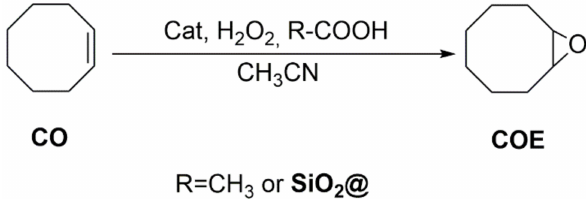
Figure 13. Catalytic oxidation of cyclooctene.